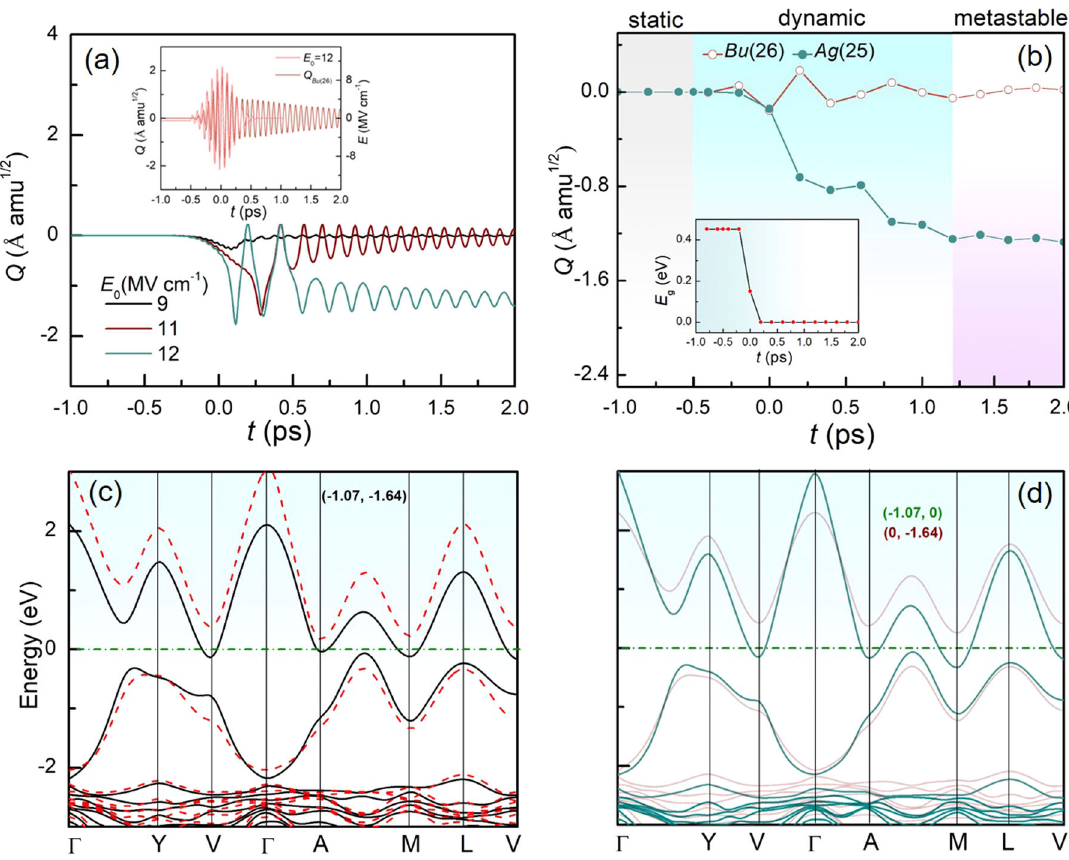
Fig. 3 Time-dependent dynamics of the coupled phonons and electronic state, and the mode contributions to electronic state change. a Time evolution of A g (25) mode nonlinearly coupled to the pumped B u (26) mode for pumped pulse with a peak electric fi eld of 9, 11, and 12 MV cm − 1 , respectively. The insert shows the time evolution of the pump pulse as high as 12 MV cm − 1 and the corresponding pumped B u (26) mode. b Time evolutions of the mean amplitudes of A g (25) and B u (26) modes at a peak electric fi eld of 12 MV cm − 1 . The insert shows time dependence of band gap. HSE-calculated band structures for c equilibrium monoclinic BaBiO 3 (red dash lines) and coupled excited modes (black lines), as well as d single excited A g (25) mode (green lines) and single excited B u (26) mode (light wine lines) with corresponding amplitudes given in parentheses for each mode as ( Q ( A g (25)), Q ( B u (26))) in units of Å amu 1/2 . The Fermi level is set to